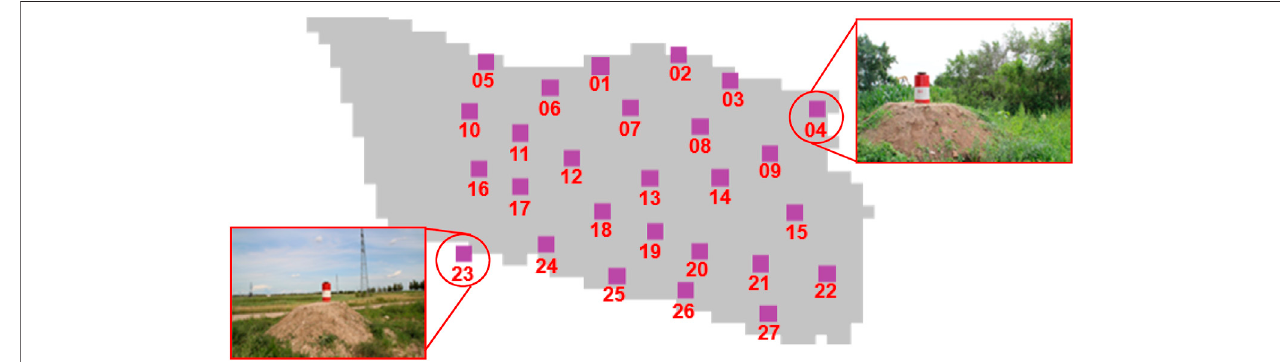
FIGURE 4 | Map showing locations of the surface displacement marker-stakes.